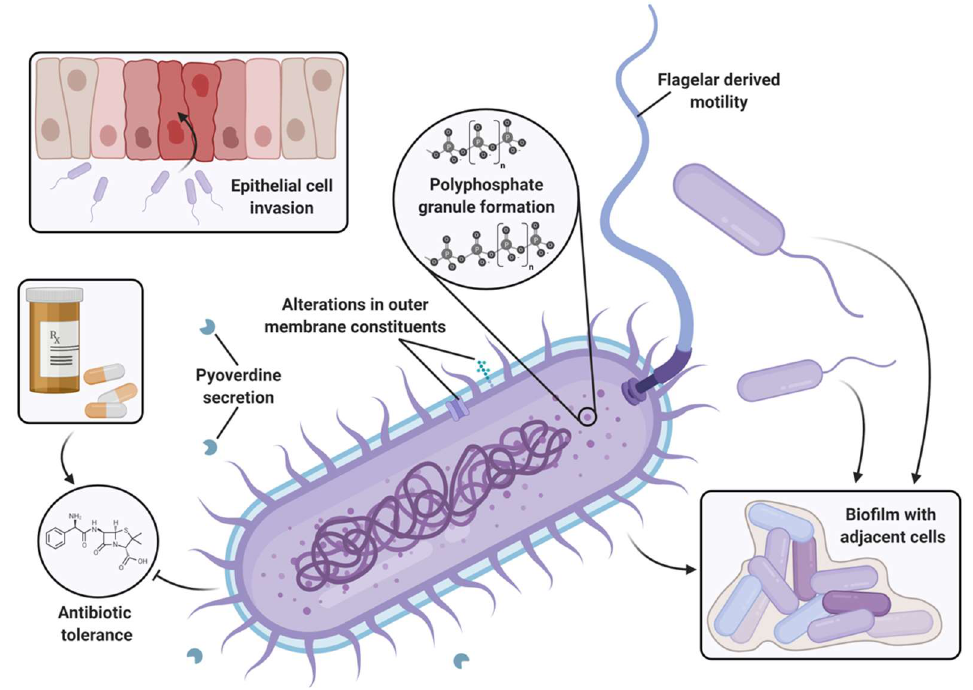
Figure 3. Schematic of bacterial virulence phenotypes linked to PPK2 enzymes. Figure created using BioRender.